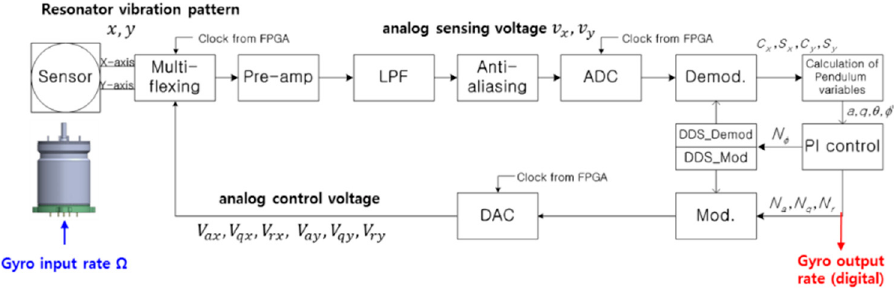
Figure 7. HRG signal processing and control circuit block diagram.